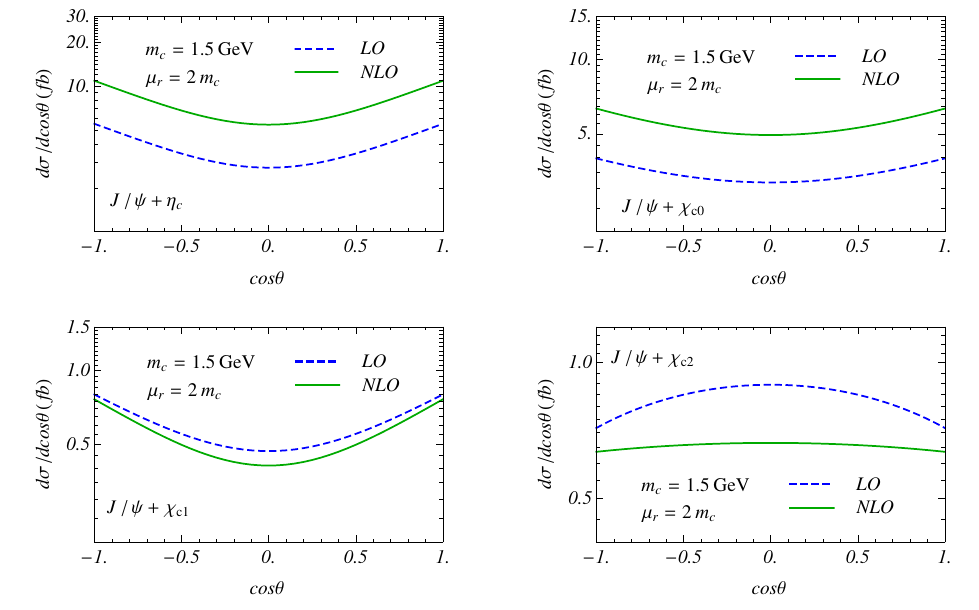
√ s = 10 . 6 GeV. m c = 1 . 5 GeV